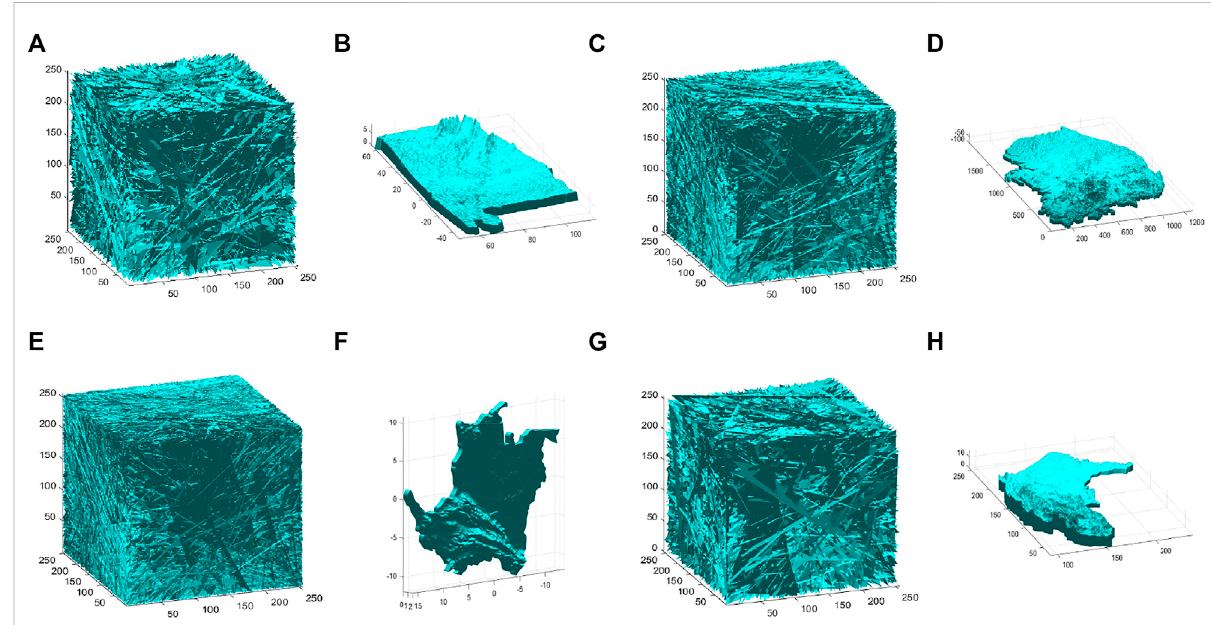
FIGURE 10 Visualization of SMCLM-3ME. (A) Encrypted topographic map of the United States. (B) Decrypted topographic map of the United States. (C) Encrypted topographic map of South Korea. (D) Decrypted topographic map of South Korea. (E) Encrypted topographic map of Colombia. (F) DecryptedtopographicmapofColombia. (G) EncryptedtopographicmapofthecapitalofAustralia. (H) Decryptedtopographicmapofthecapitalof